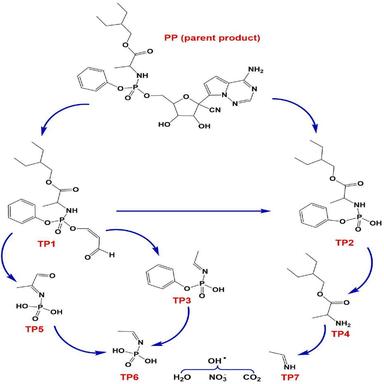
The proposed pathways for RDV oxidation in the photocatalytic process.